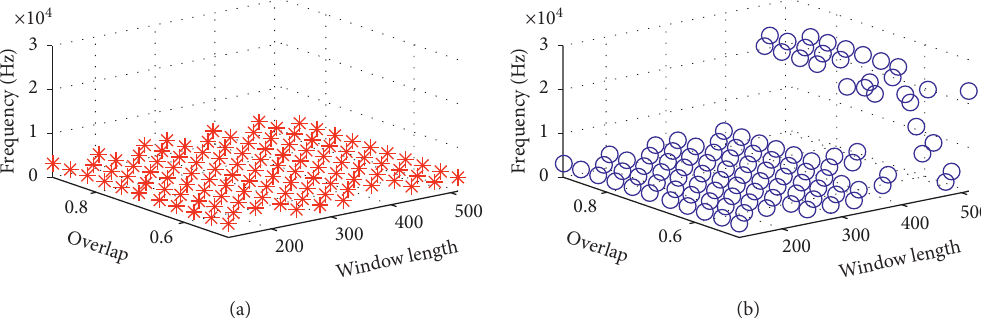
Figure 15: ICFs located by the proposed method and EFS with the experimental signal in Figure 14(a). (a) Envelope negentropy. (b) Energy